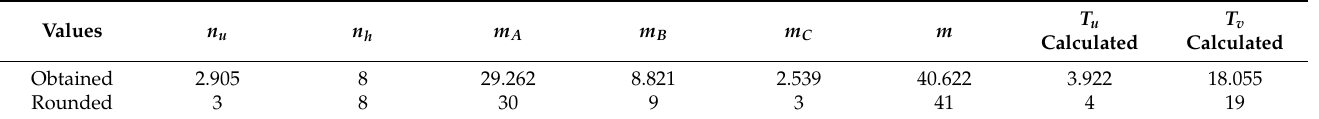
Table 5. Results of applying the formulas to the warehouse of the Glavima company without area restriction.